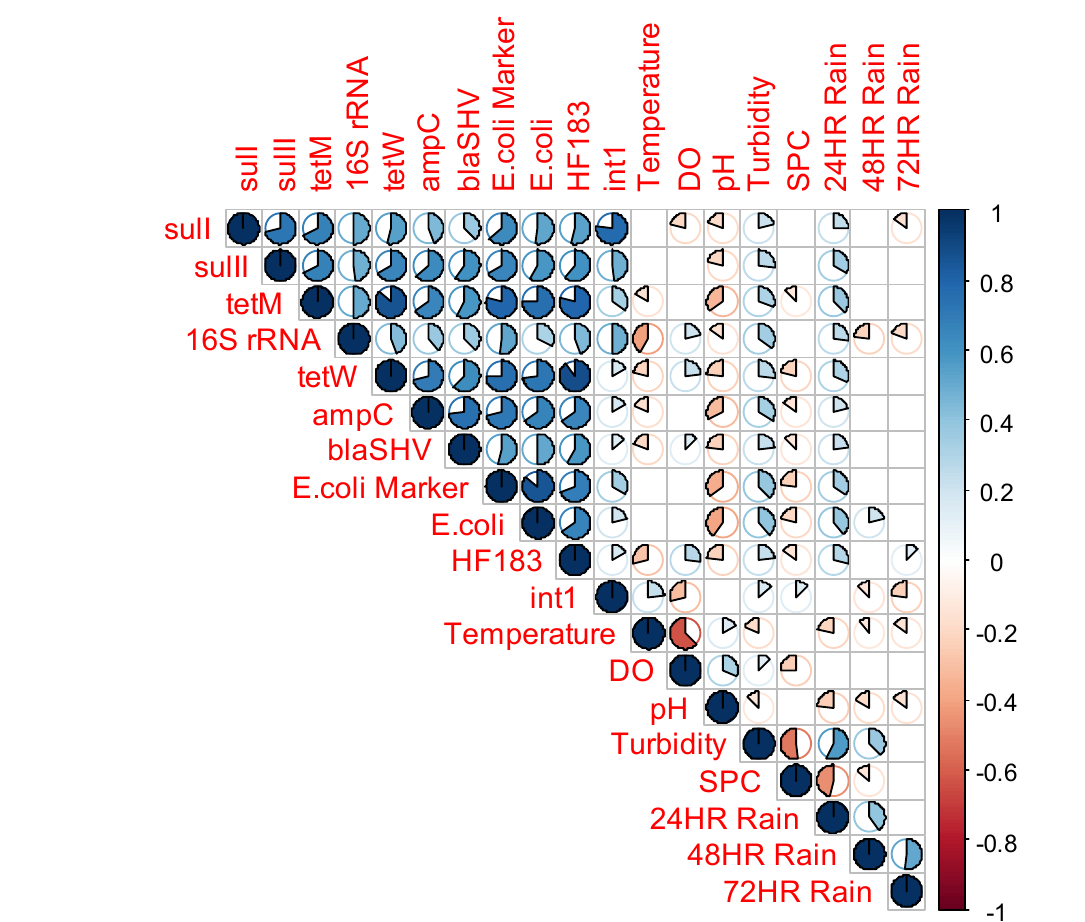
Figure 4. Spearman rank correlations among ARGs, fecal markers, int1 gene, 16S rRNA, standard water quality parameters, and antecedent rainfall. The correlation r is represented by the area of the pie.